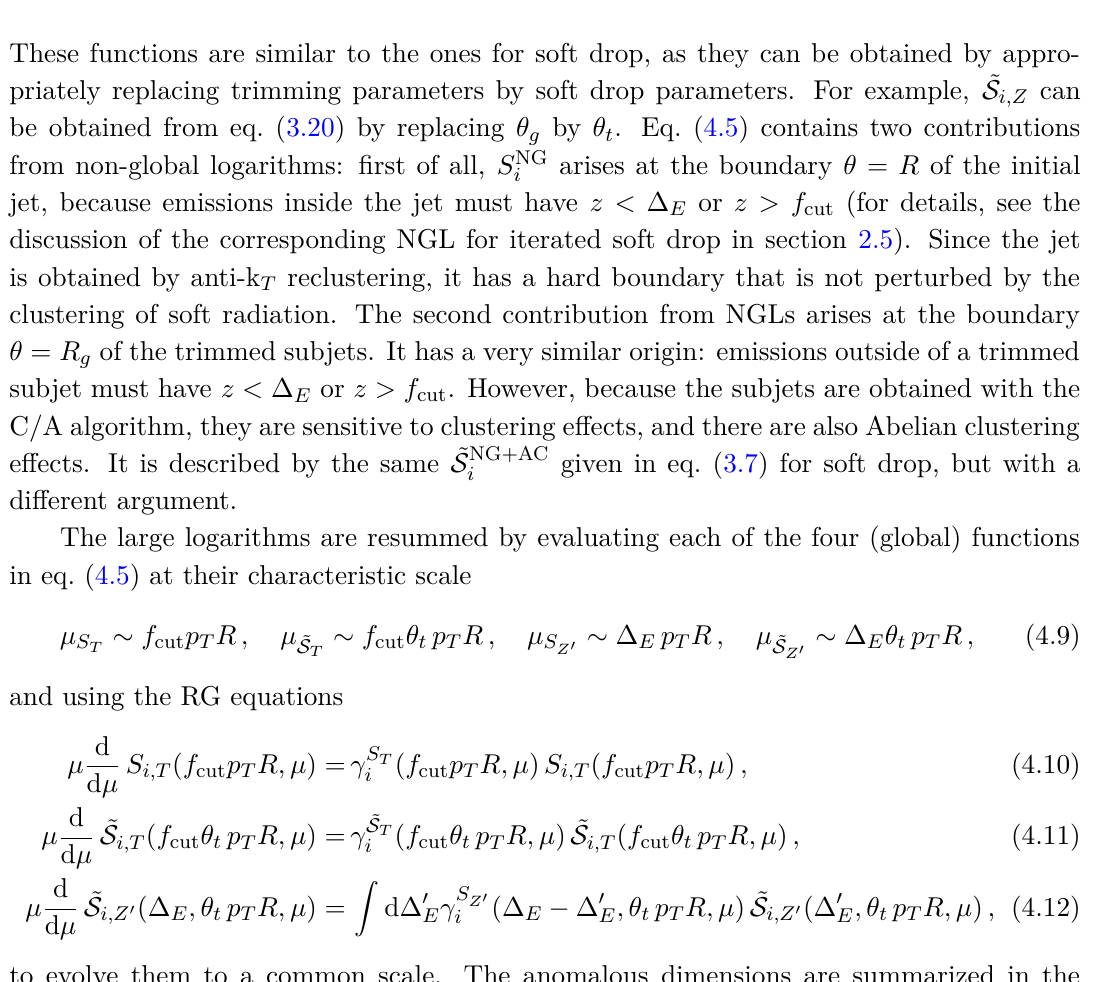
can i,Z by θ . Eq. (4.5) contains two g t